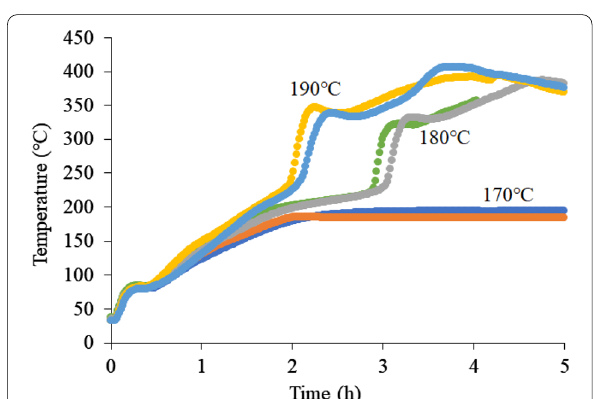
Fig. 4 Ignition of cedar sawdust at each temperature. Each experiment was performed in